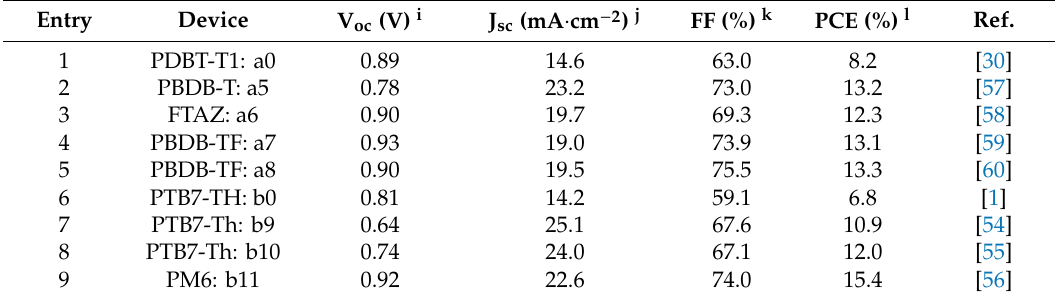
Table 4. Photovoltaic properties of the best devices incorporating NFA acceptors shown in Figure